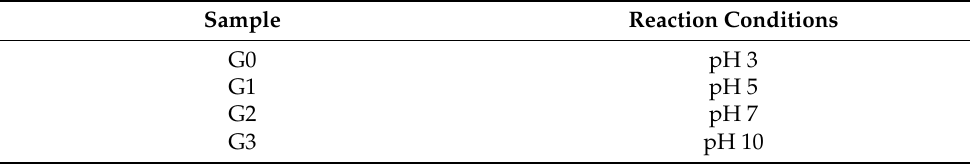
Table 4. Symbols and pH conditions of the prepared